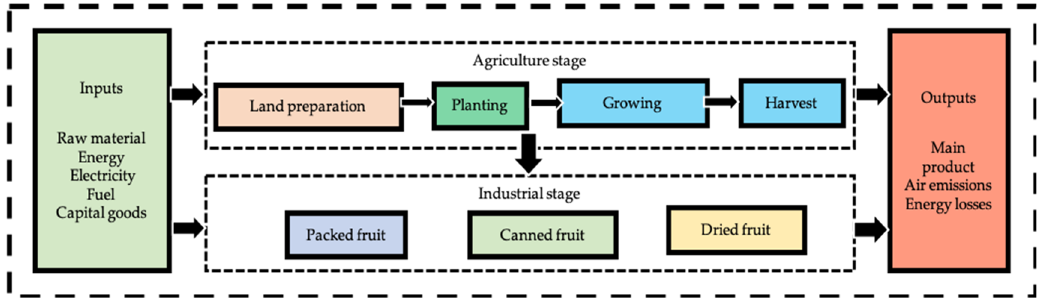
Figure 2. General diagram of the agricultural and industrial production process. Source: own elaboration.